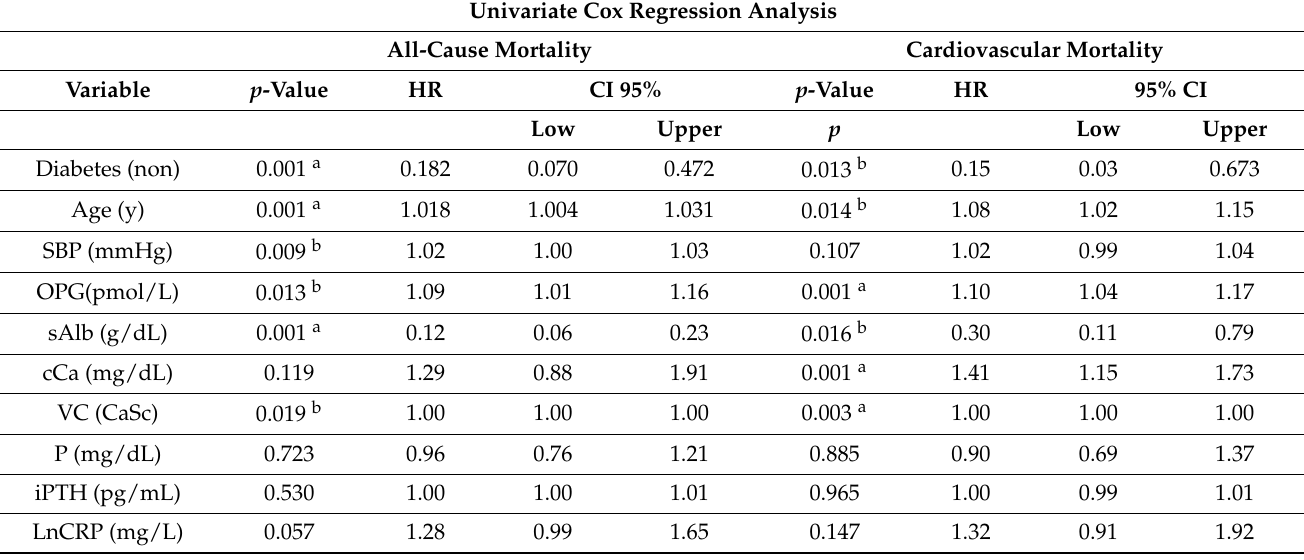
Table 4. Factors associated with all-cause and cardiovascular mortality in peritoneal dialysis patients. Univariate Cox Regression Analysis